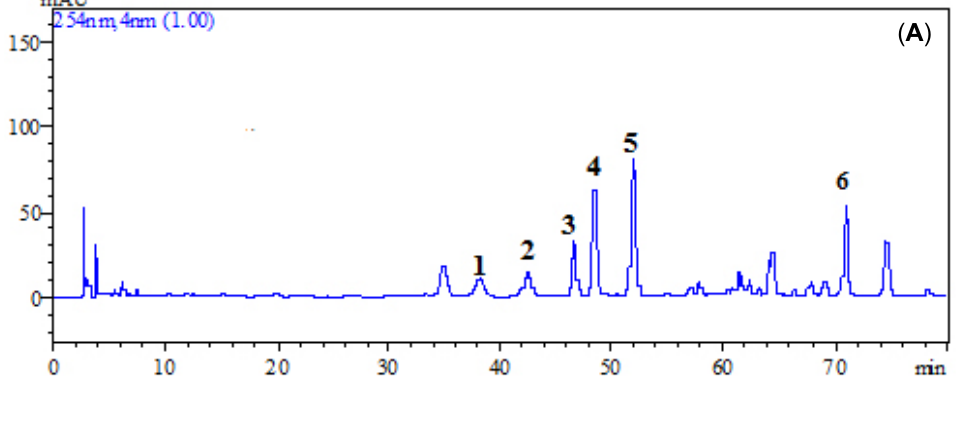
Figure 3. HPLC chromatograms of ethyl acetate extract from P. guajava leaves and HSCCC peak fractions. ( A ) Ethyl acetate extract from P. guajava leaves, ( B – C ) the